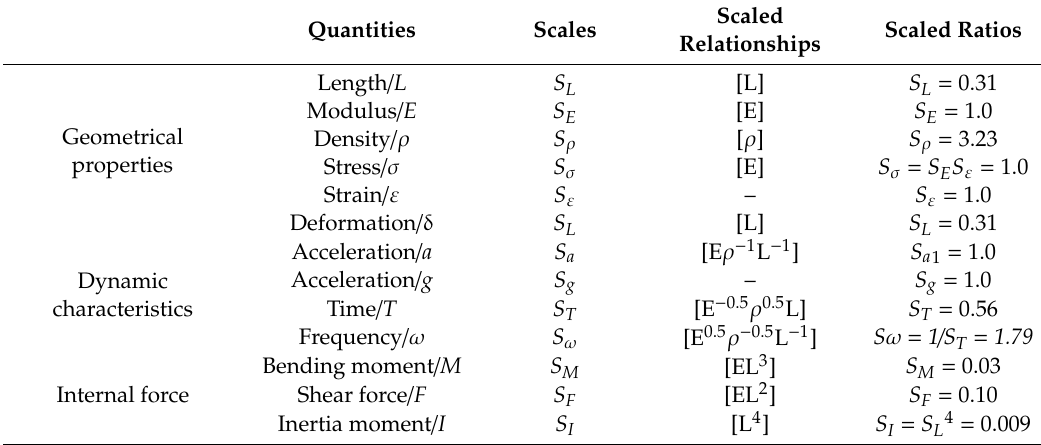
Table 1. Similarity coe ffi cients.